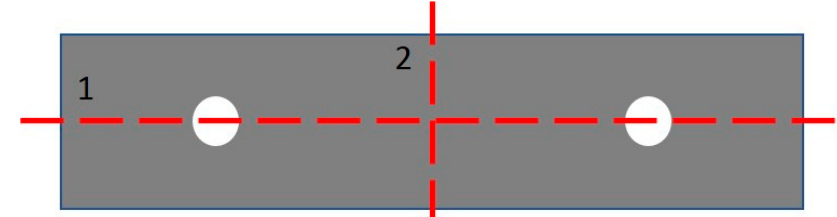
Figure 6. Alternative apparent strain removal method applied by MM. The difference between strain measurement in direction 1 and 2 can offset the amount of apparent strain included in both directions.